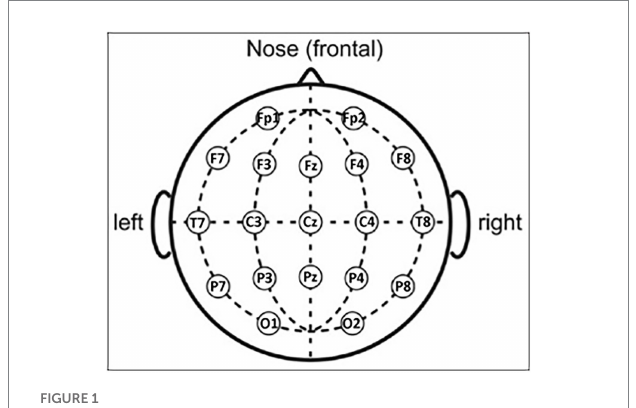
FIGURE 1 Scalp electrode positioning of the 19 electrodes according to the international standard